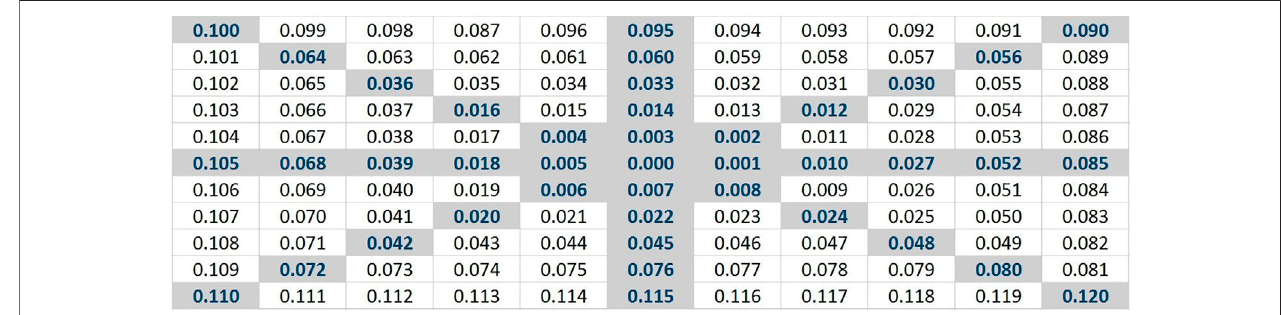
FIGURE 5 | Gann ’ s square of nine (Mikula, 2003) for determining the unavailability.